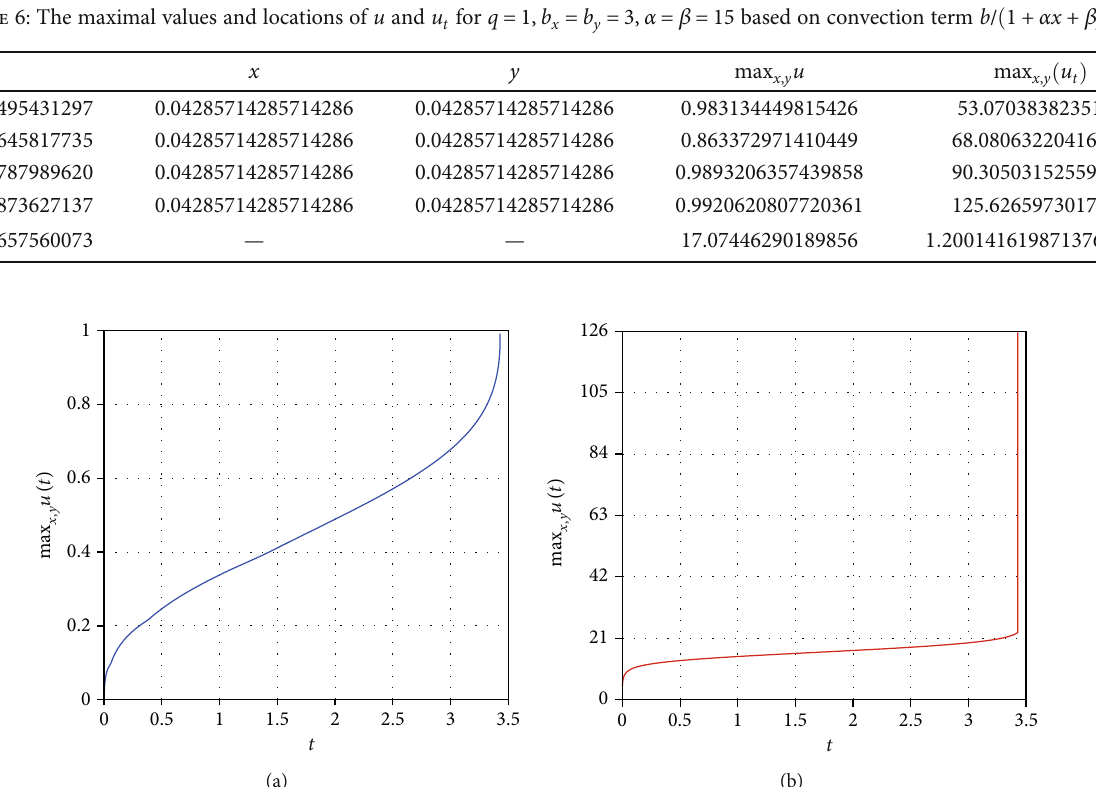
u t increases from the initial moment to the x , y ð t Þ as